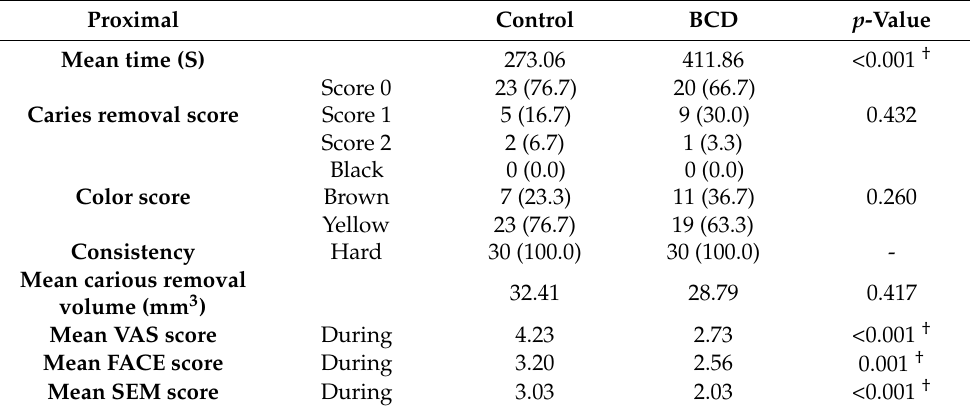
Table 2. Mean time, caries removal score, color score, consistency score and volume, mean VAS, FACE, and SEM at baseline, during procedure, after completion and at 24 h among the groups (Proximal caries). Proximal Control BCD p -Value Mean time (S) 273.06 411.86 <0.001 † Score 0 Caries removal score Score 1 Score 2 Black Color score Brown Yellow Consistency Hard 32.41 volume (mm 3 ) Mean VAS score